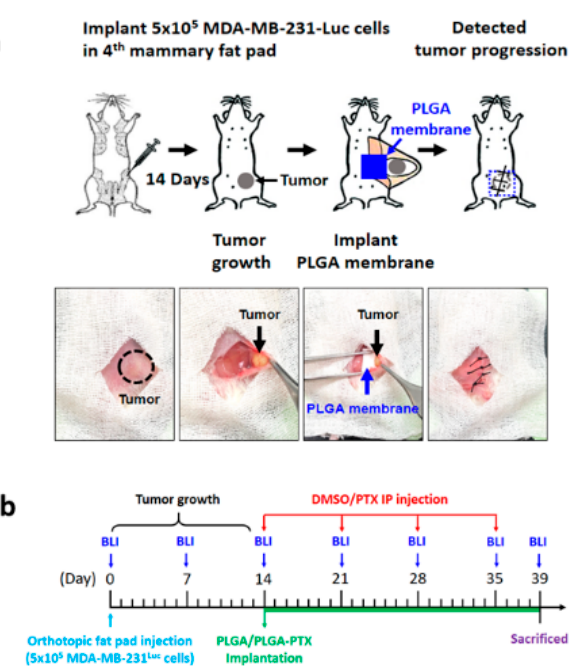
Figure 5. Illustration of the orthotopic breast cancer mouse model and process of drug administration. ( a ) Schematic picture of the mammary gland transplantation procedure. MDA-MB-231-Luc cells were